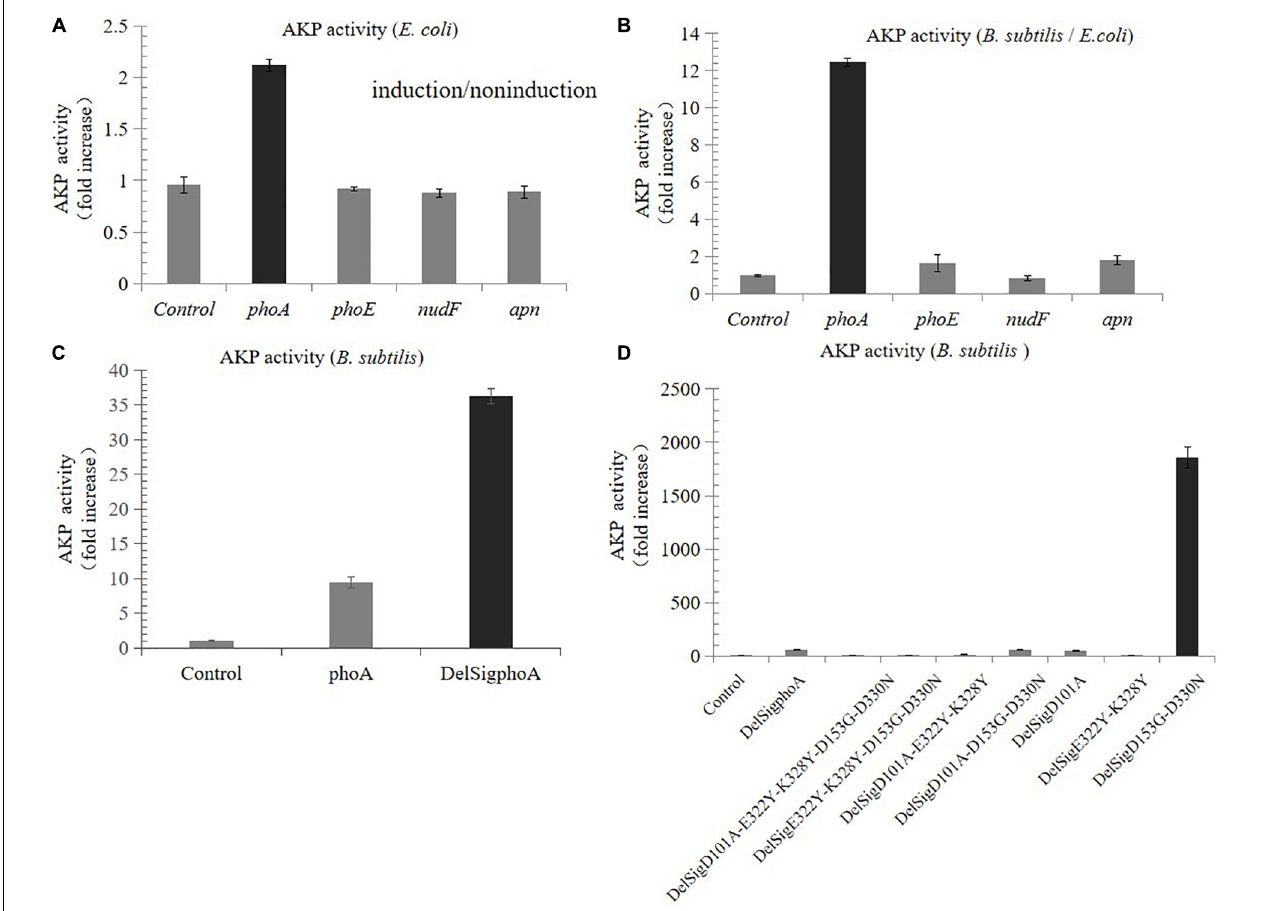
FIGURE 1 | Screening and improving enzyme activity of AKP. (A) Fold increase in the AKP activity in Escherichia coli by tetracycline inducible promoter. (B) Fold increase in the AKP activity in Bacillus subtilis compared with E. coli . (C) Fold increase in the AKP activity without signal peptide and with signal peptide in B. subtilis . (D) Fold increase in the AKP activity in B. subtilis by point mutation. Control is empty vector in E. coli or B. subtilis . Error bars, SD; n = 3.